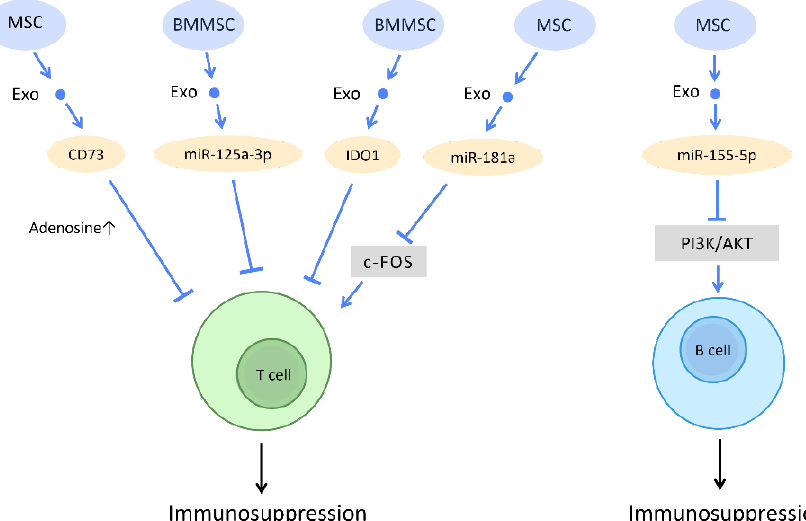
Figure 10. Immunosuppressive effect of stem cell-derived exosomes. Through regulating T cells and B cells function, stem cell-derived exosomes often attenuate inflammatory responses and promote a tolerogenic immune environment. Abbreviation: Exo: exosome; miR: micro-RNA; MSC: mesen- chymal stem cell; BMMSC: bone